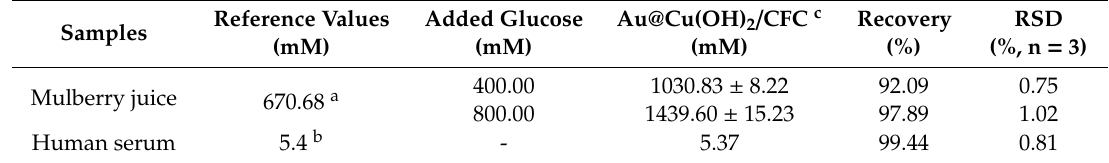
Table 1. The detection of glucose concentrations in the human serum sample and mulberry drink. Reference Samples